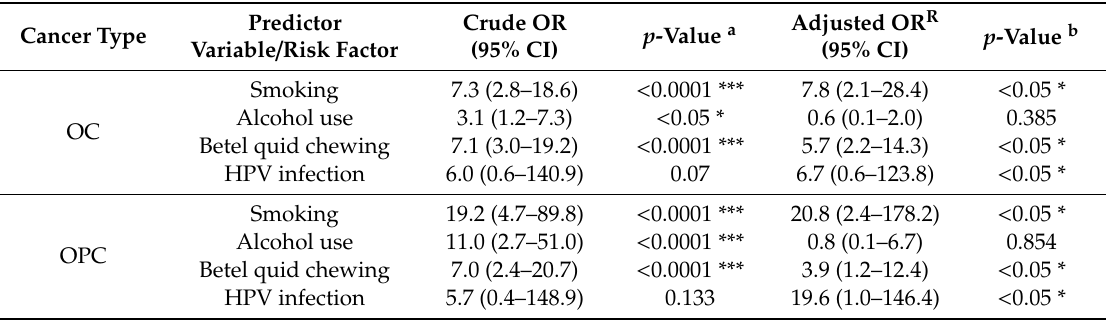
Table 3. Combined and independent e ff ects of established and emerging risk factors of OC and OPC.